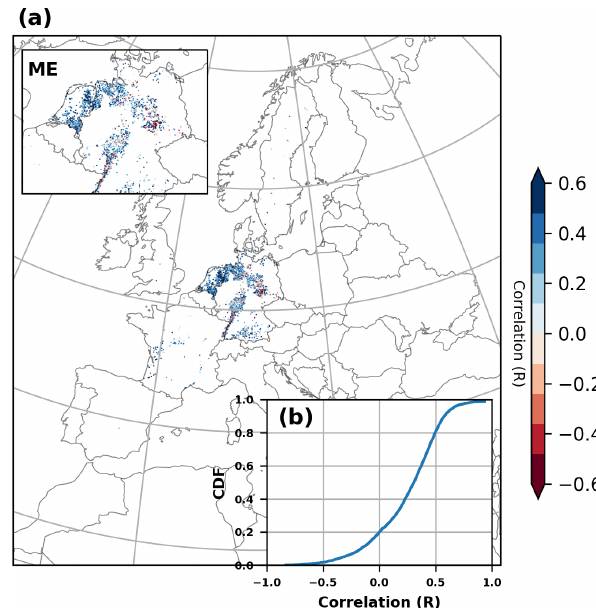
Figure 8. (a) Correlation map between in situ water table depth (WTD) anomalies and ParFlow-CLM model. (b) Cumulative distri- bution function (CDF) of correlation coefficient of ParFlow-CLM with observed WTD anomalies. The inset in (a) shows a zoom of the mid-Europe (ME)